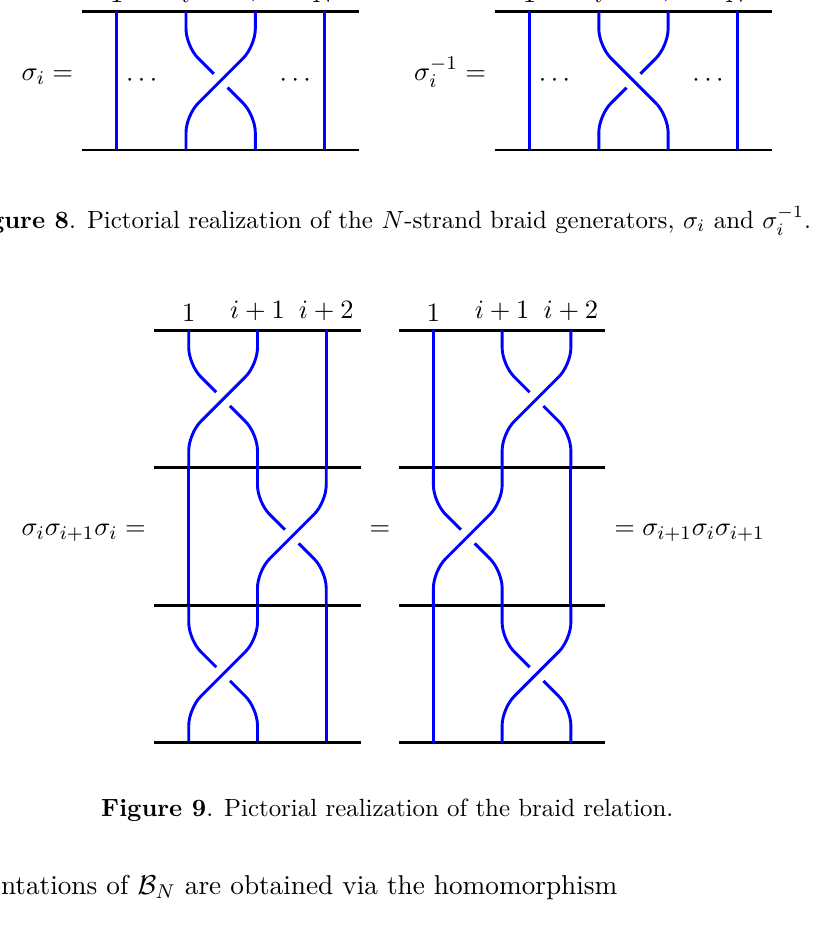
Figure 9 . Pictorial realization of the braid